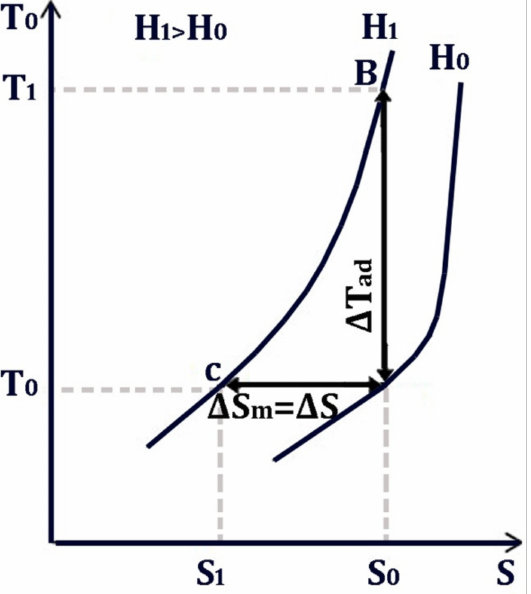
Figure 1. Temperature and entropy as a function of the external magnetic field applied to the material